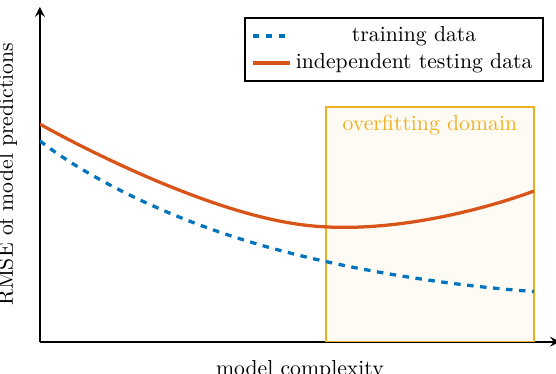
Figure 2. Typical behavior of the root mean square error (RMSE) of model predictions with increasing number of predictors (which amounts to an increase in model complexity); see [18] (pp. 37–38), [19] (pp.